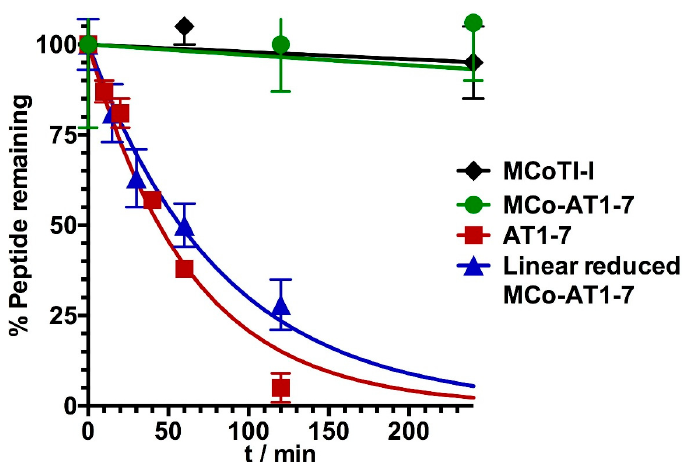
Figure 4. Stability of cyclotides MCo-AT1-7 and MCoTI-I, and peptide AT1-7 and reduced linear MCo-AT1-7 precursor to human serum at 37 °C. Undigested peptides were quantified by HPLC-MS/MS.